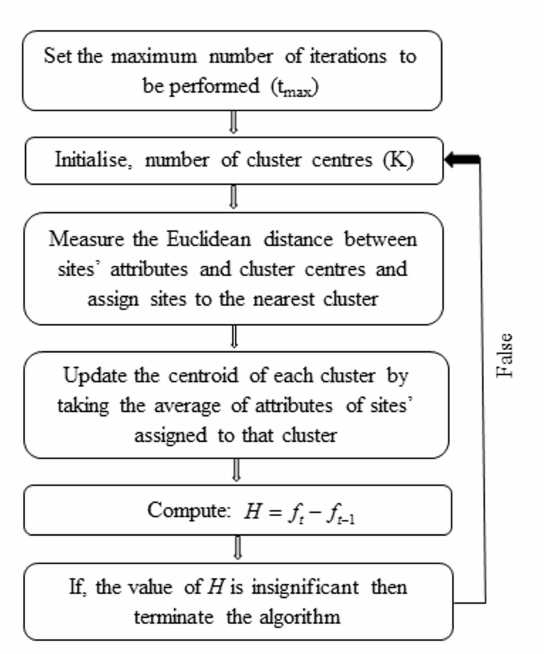
Figure 2. Steps involved in k-means clustering